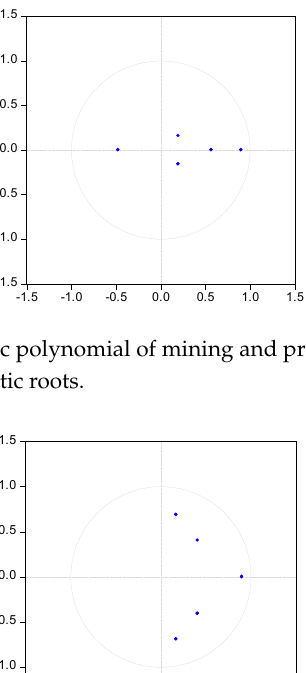
Figure 4. VAR roots of characteristic polynomial of extraction of petroleum and natural gas. Note: blue dots indicate characteristic roots.